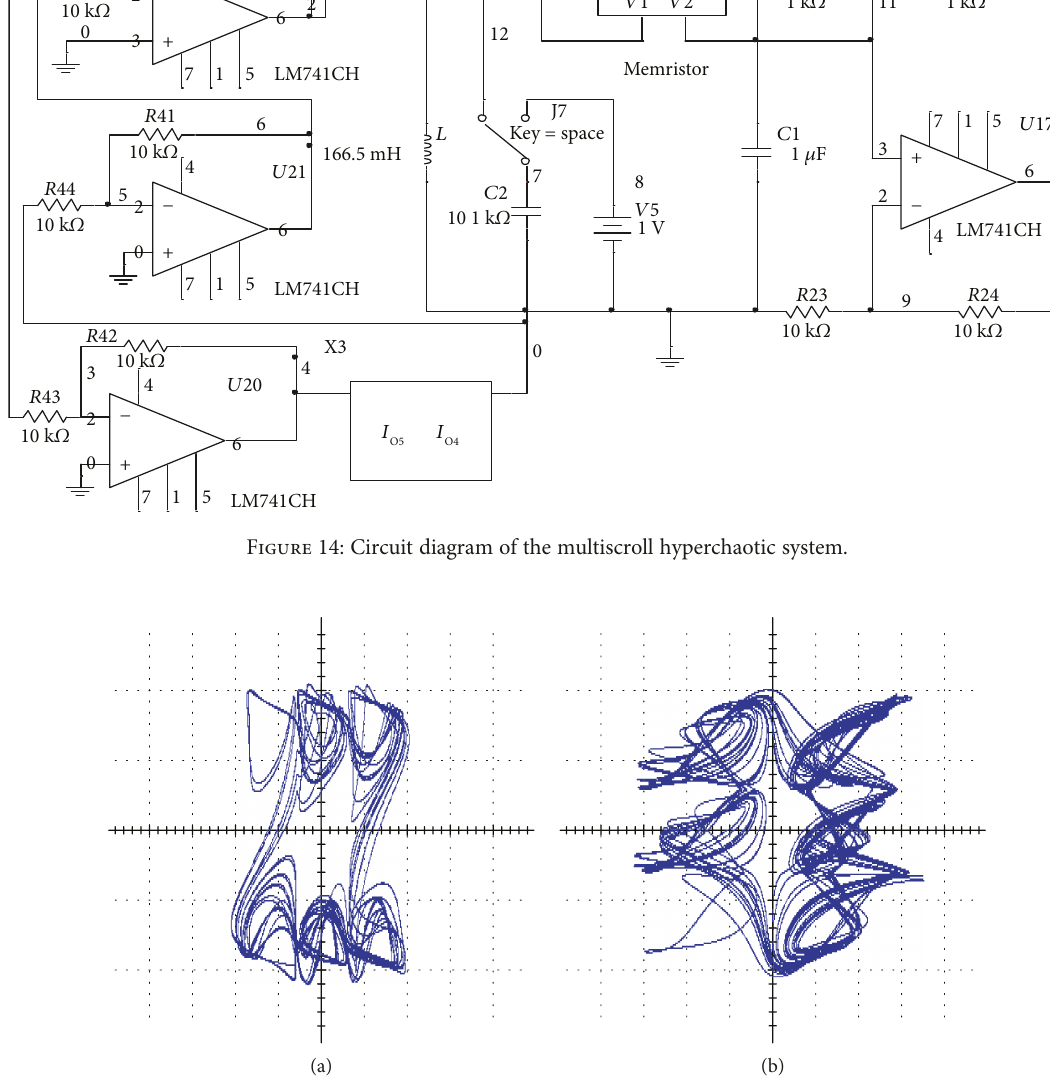
Figure 15: Circuit implementation of the multiscroll hyperchaotic system. (a) y , w plane. (b) x , y plane.